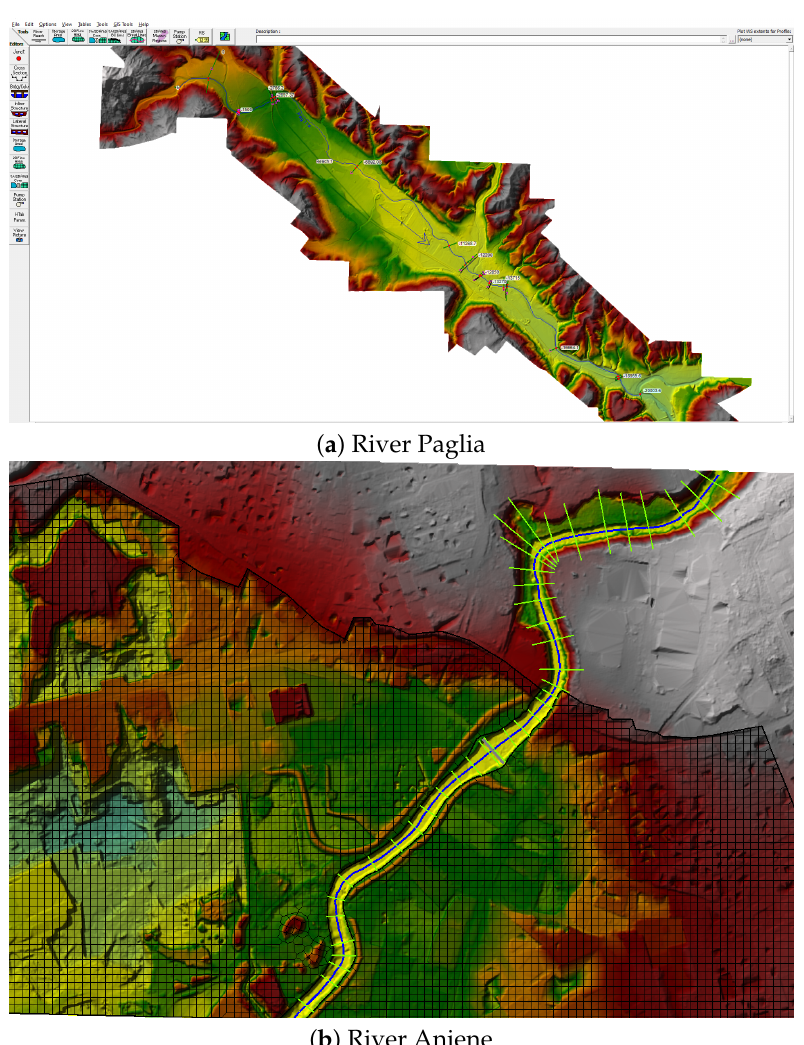
Figure 1. DEM images displaying the cross-sections for the two rivers Paglia ( a ) and Aniene ( b